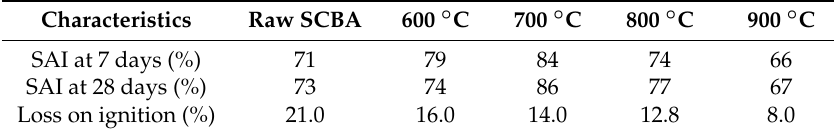
Table 4. Physical characteristics of burnt samples [30].